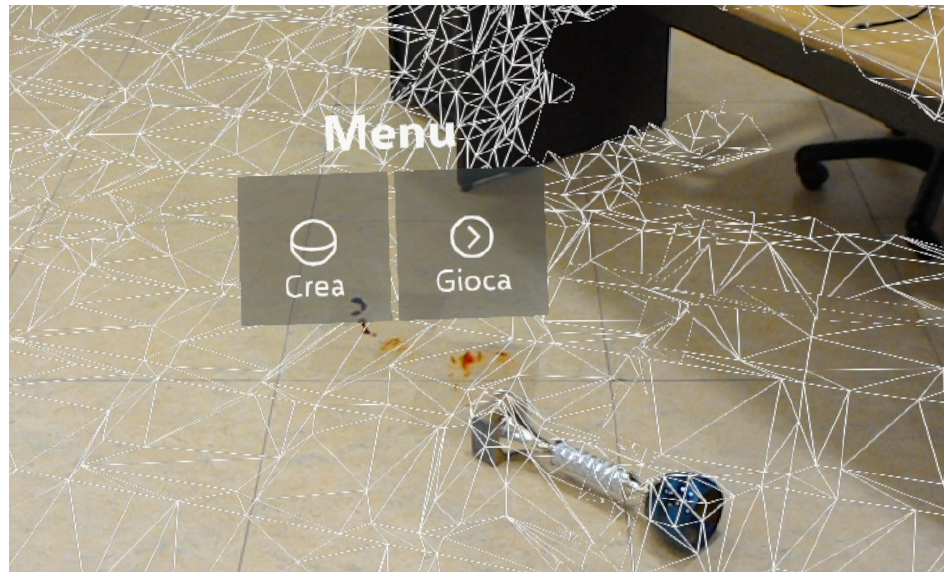
Figure 2. Start menu of TraceGame. The Crea label is used to activate the scenario creation mode, whereas the Gioca label is used to activate the game session